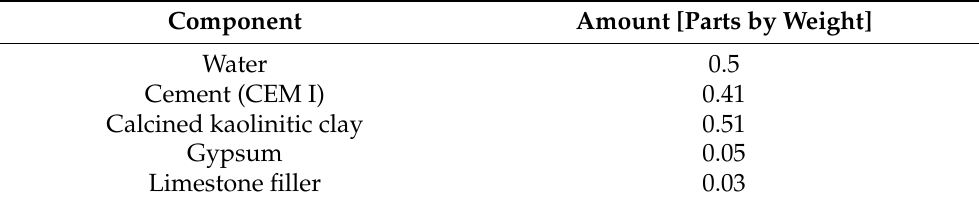
Table 2. The cement paste composition given in parts by weight with a water to binder ratio of 0.5.